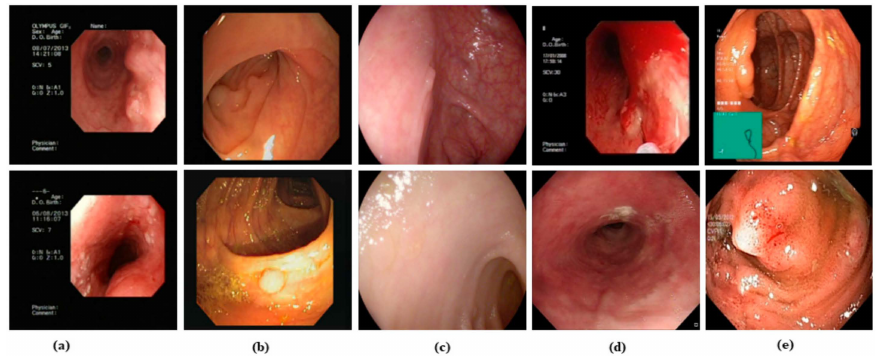
Figure 1. Sample raw GI images. ( a ) GI images with the small and large lesion region (lab), ( b ) CVC-ClinicDB polyp images with small and large lesion region [24], ( c ) ETIS-LaribPolypDB polyp images [25], ( d ) EDA2019 challenge images [26], and ( e ) Kvasir-SEG images dataset with small and large lesions region